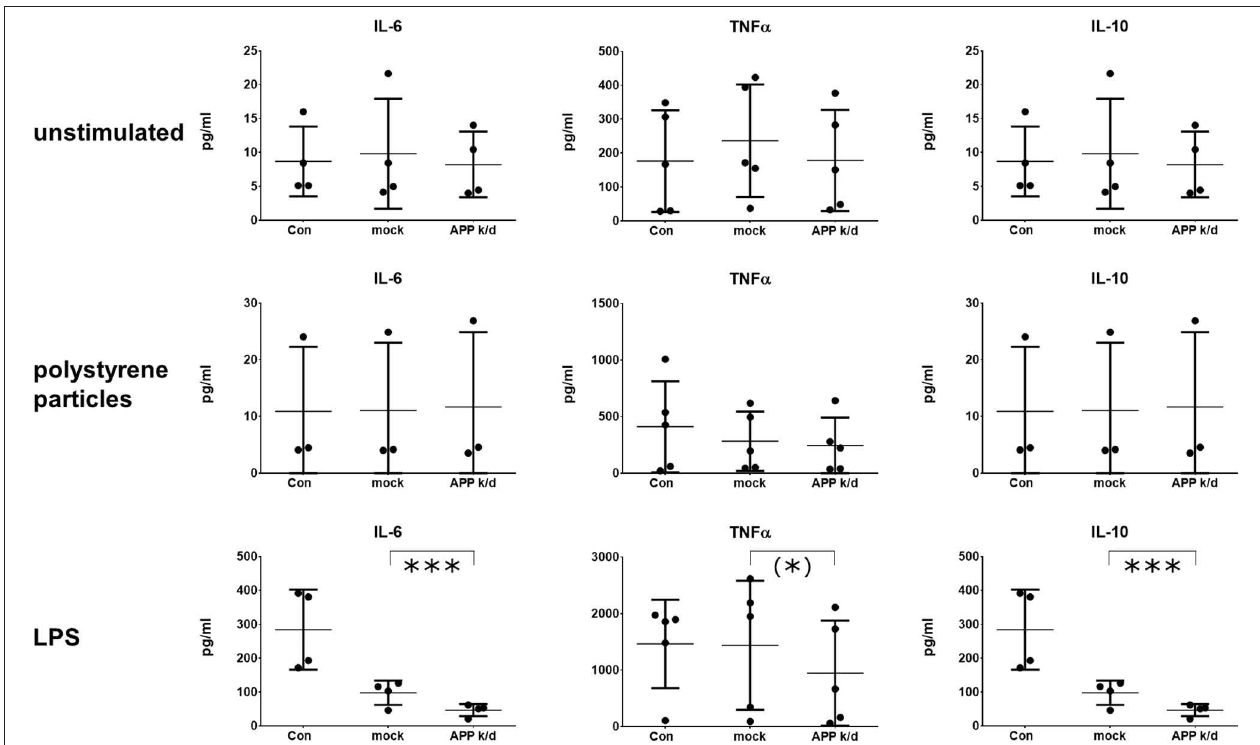
FIGURE 3 | Reduced secretion of IL-6 and IL-10 after knock-down of APP. IL-6 ( n = 4), TNF α ( n = 5), and IL-10 ( n = 4) were determined by ELISA in cultures of primary human monocyte derived macrophages. Cultures were unstimulated (upper row), stimulated with 1 µ m polystyrene particles (seven particles/cell) (middle row), or stimulated with 10ng/ml LPS (bottom row). The expression of APP was inhibited by transfection with siRNA. Cultures transfected with non-coding siRNA served as control (mock). Results are presented as mean with standard deviation. ELISA were carried out in duplicates. Each point represents a biological replicate and is the mean value of the duplicates. Significance of the differences was evaluated with the ratio-paired t -test between mock-transfected and APP-transfected macrophages. (*) p < 0.1 (trend); *** p <